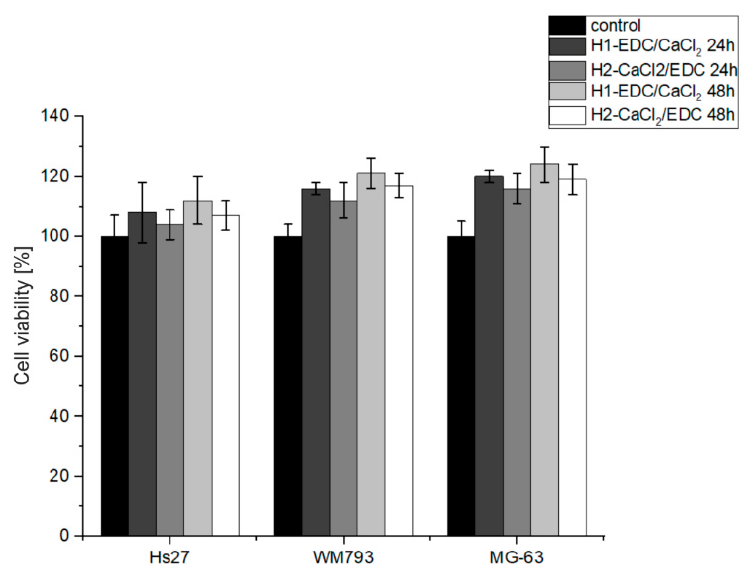
Figure 11. The results of the MTT assay performed for both hydrogels on the Hs27, WM793 and MG-63 cell lines.